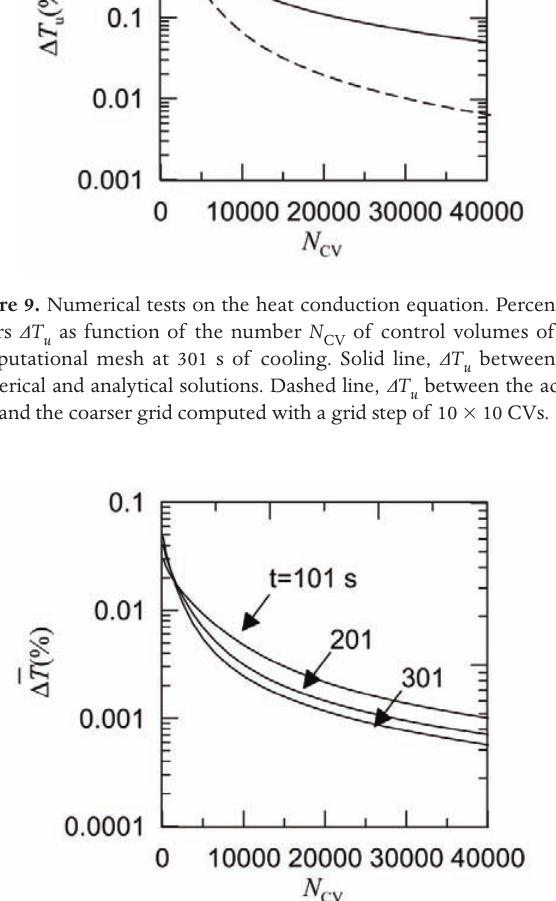
Figure 10. Numerical tests on the heat conduction equation. Percentage errors as a function of the number N of control volumes of the CV computational mesh at different times t = 101, 201, 301 s of